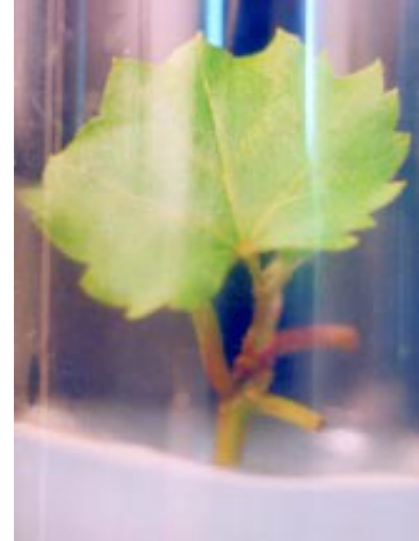
Fig. 4. Loss of grape leaf characteristics (symptom of infectious